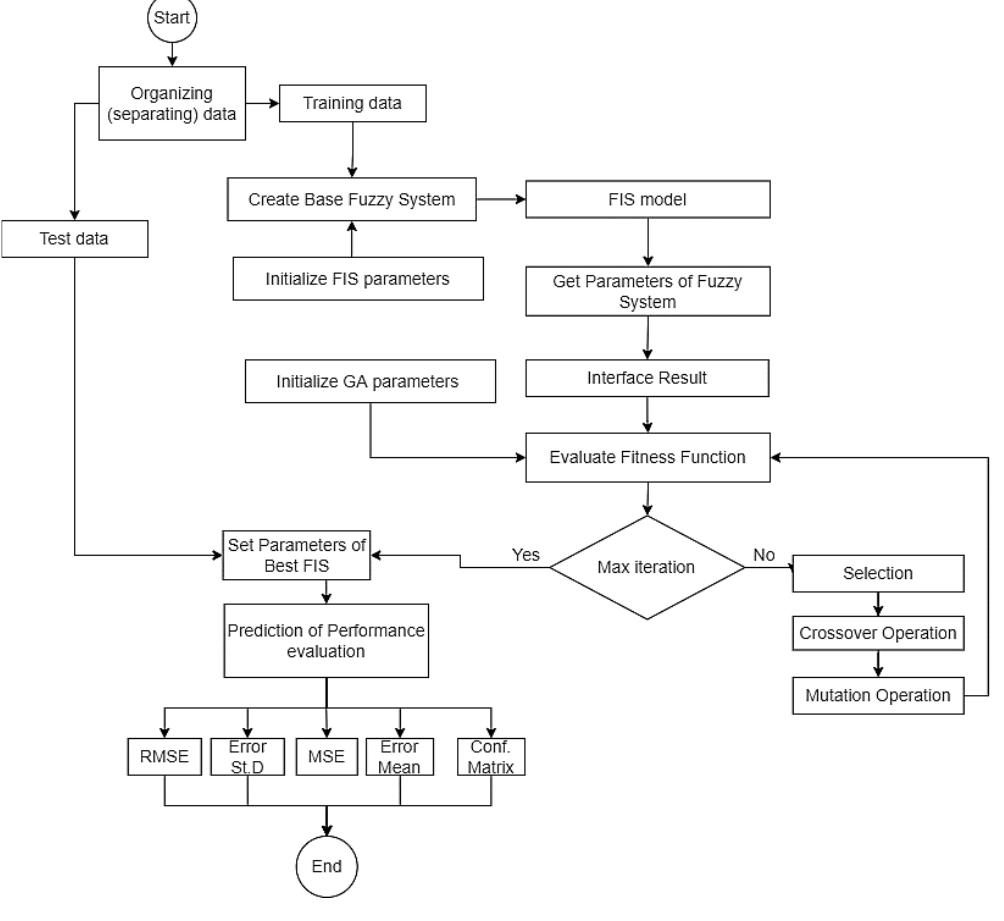
Fig. 3. Flowchart of